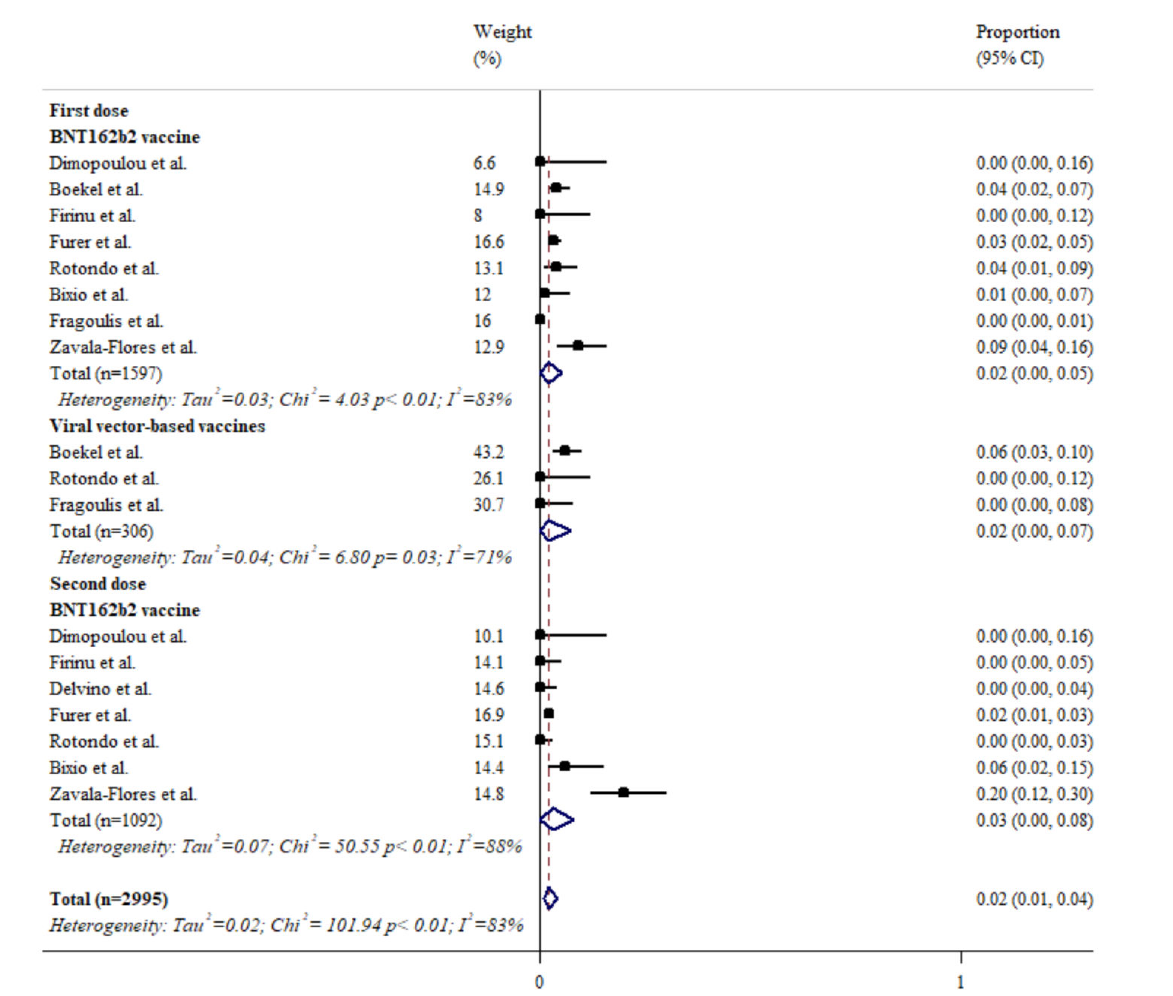
Figure 5. The incidence rate of disease flares after COVID vaccination. The black squares represent the effect estimates of the individual studies and the diamonds represent the summary effect